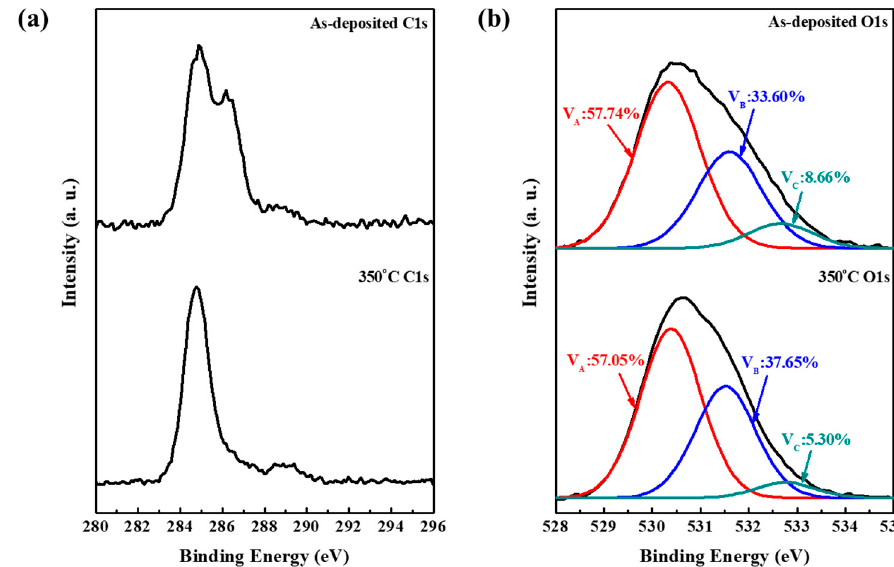
Figure 4. Comparison of XPS spectra in the channel region of Device A with/without thermal annealing process of 350 °C in air ambient: ( a ) C1s spectra and ( b ) O1s spectrum.